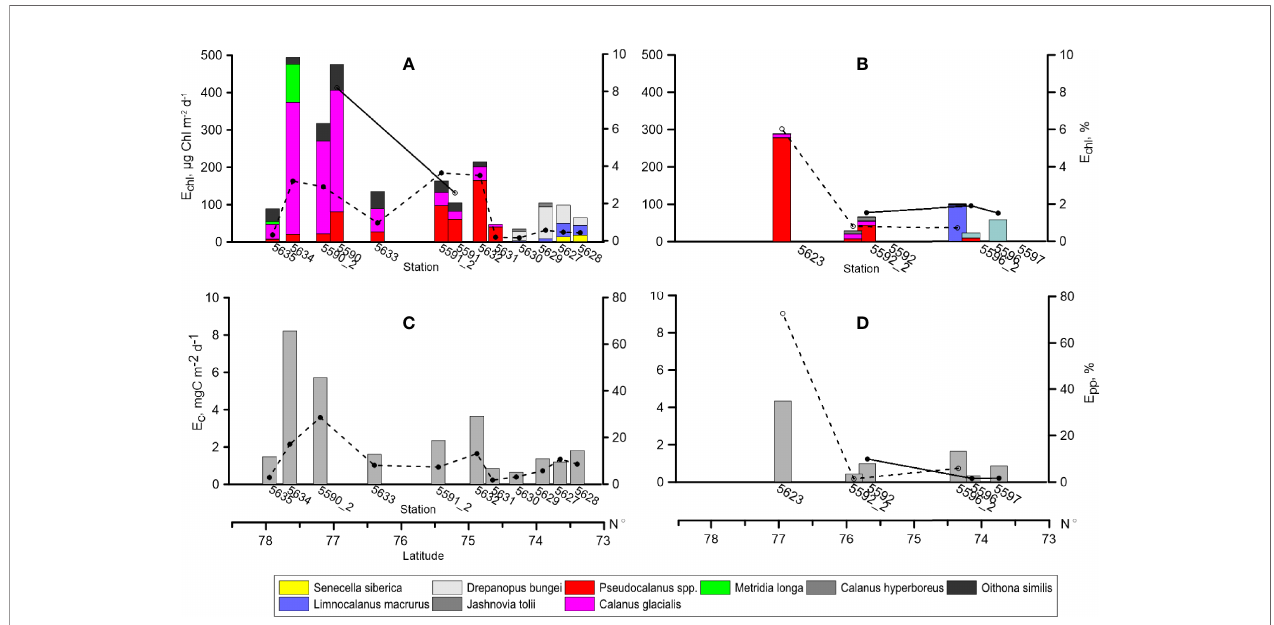
FIGURE 8 | Grazing of dominant zooplankton species in terms of Chl a (E chl ), (A, B) and organic carbon (E c ), (C, D) , bars. Lines: daily grazing impact on phytoplankton standing stock (E chl , %) and grazing as percentage of primary production (E pp , %). Solid line - fi rst sampling (31.08-3.09. 2017), dashed line - repeated sampling (14.09-20.09.2017). Left: Khatanga area, right: Lena